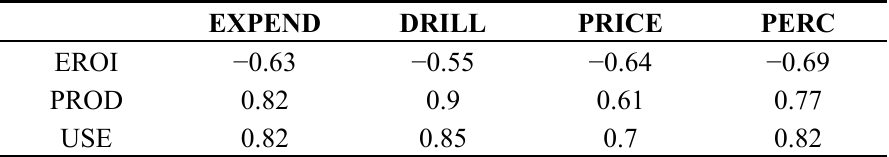
Table 6. Pearson Correlation coefficients of dependent and independent